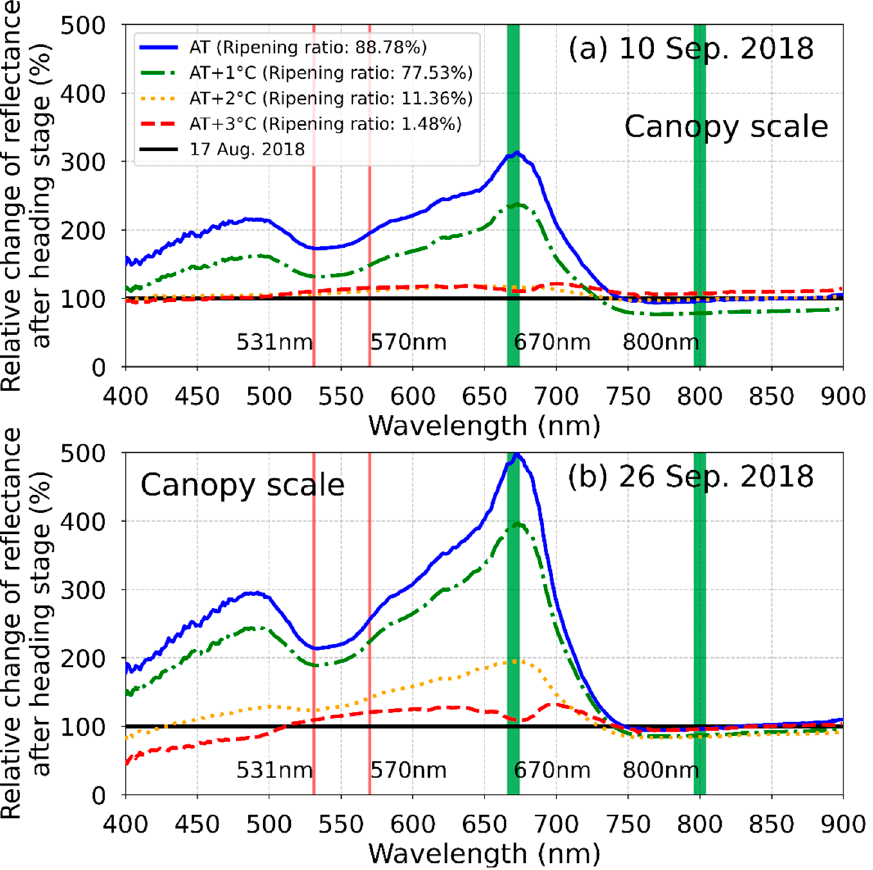
Figure 9. Relative change of reflectance measured from field-spectrometers (canopy scale) after heading stage of paddy rice at AT, AT+1 °C, AT+2 °C, and AT+3 °C positions on 10 September 2018 ( a ) and 26 September 2018 ( b ). The vertical red lines indicate the 531 nm and 570 nm values used to compute PRI, and the vertical green lines denote the 670 nm and 800 nm values used to calculate NDVI. The black solid lines represent the standard lines, which are based on the spectral reflectance measured on 17 August 2018.